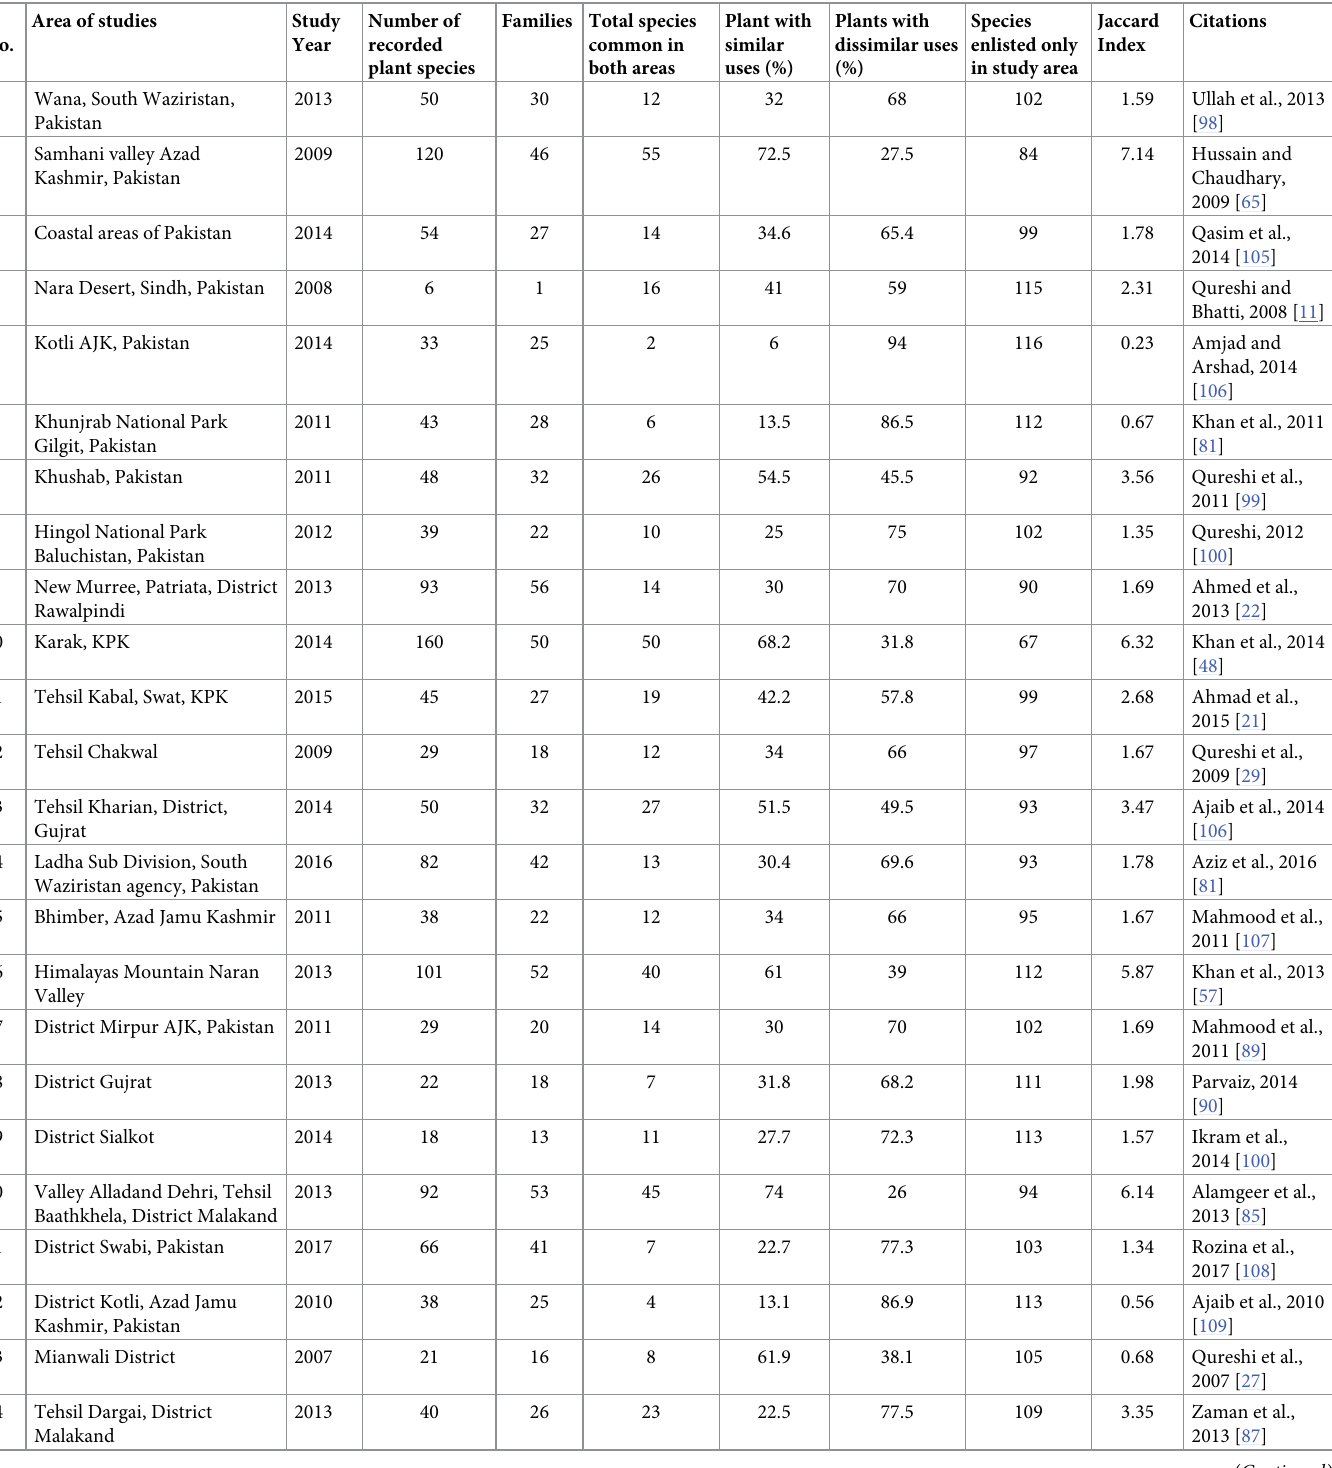
Table 5. Comparison with adjacent regions national as well international reports